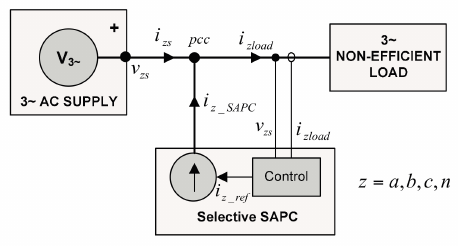
Figure 1. Block diagram showing the connection of a SAPC to the power network at the pcc